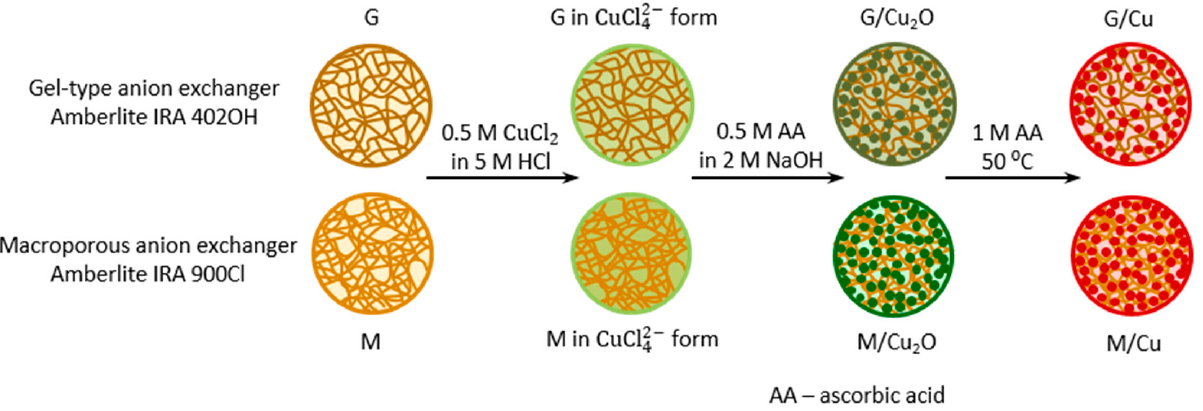
Table 1. Materials used for